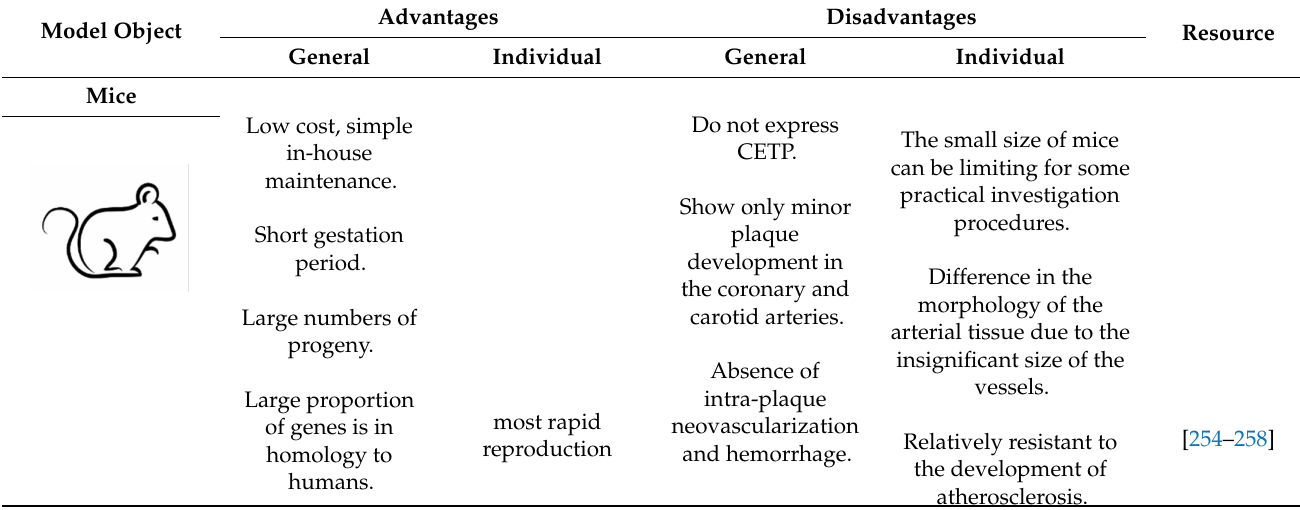
Table 4. Small mammals used as models to study the relationship between atherosclerosis and